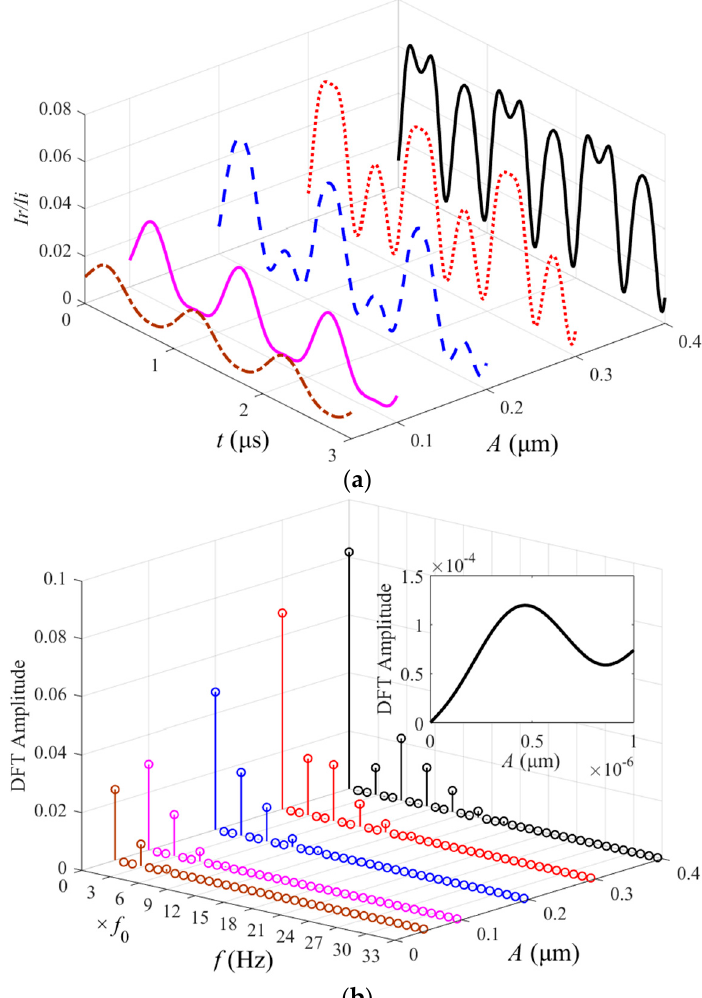
Figure 3. The effect of A on I r / I i . ( a ) Time ‐ domain waveforms. ( b ) Frequency ‐ domain waveforms. Inset: the discrete Fourier transform (DFT) amplitude ‐ A response at f 0 .